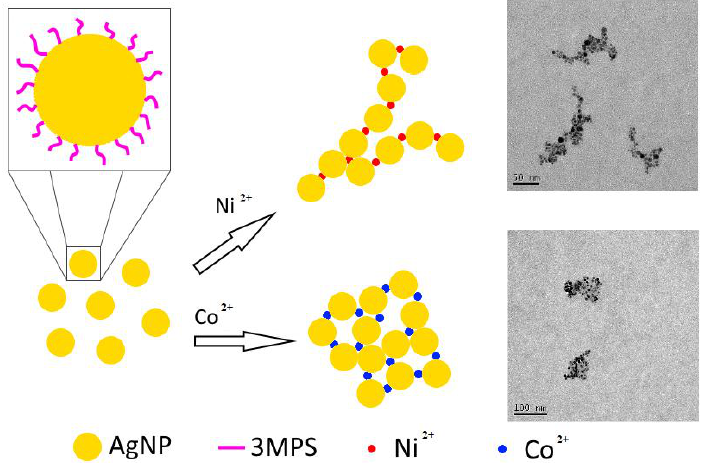
Figure 6. Scheme illustrating the different shape of the aggregates in presence of nickel and cobalt ions.